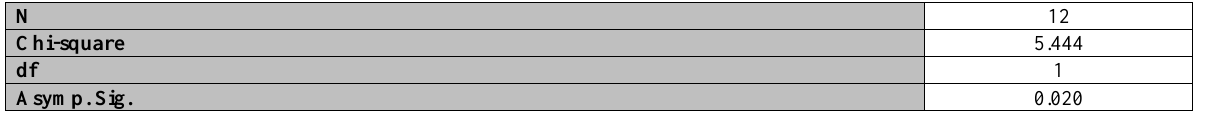
Table 3. A Lack of Effective Plans for Addressing Supply Chain Disruptions (Friedman)